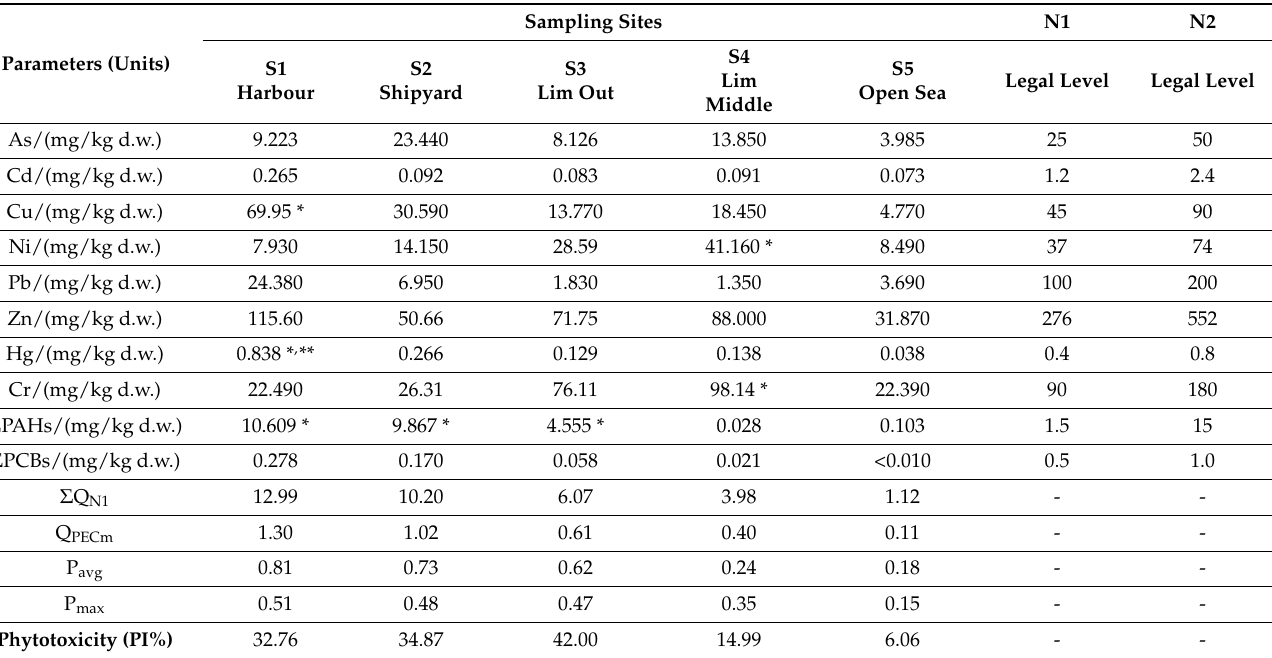
Table 2. Results of sediment chemical analyses and contamination evaluation: Σ Q N1 —cumulative risk quotients, Q PECm —averaged risk quotient according to French N1 and N2 level regulatory management, (P avg , P max )—probability of toxic effects and (PI)—Phytotoxicity